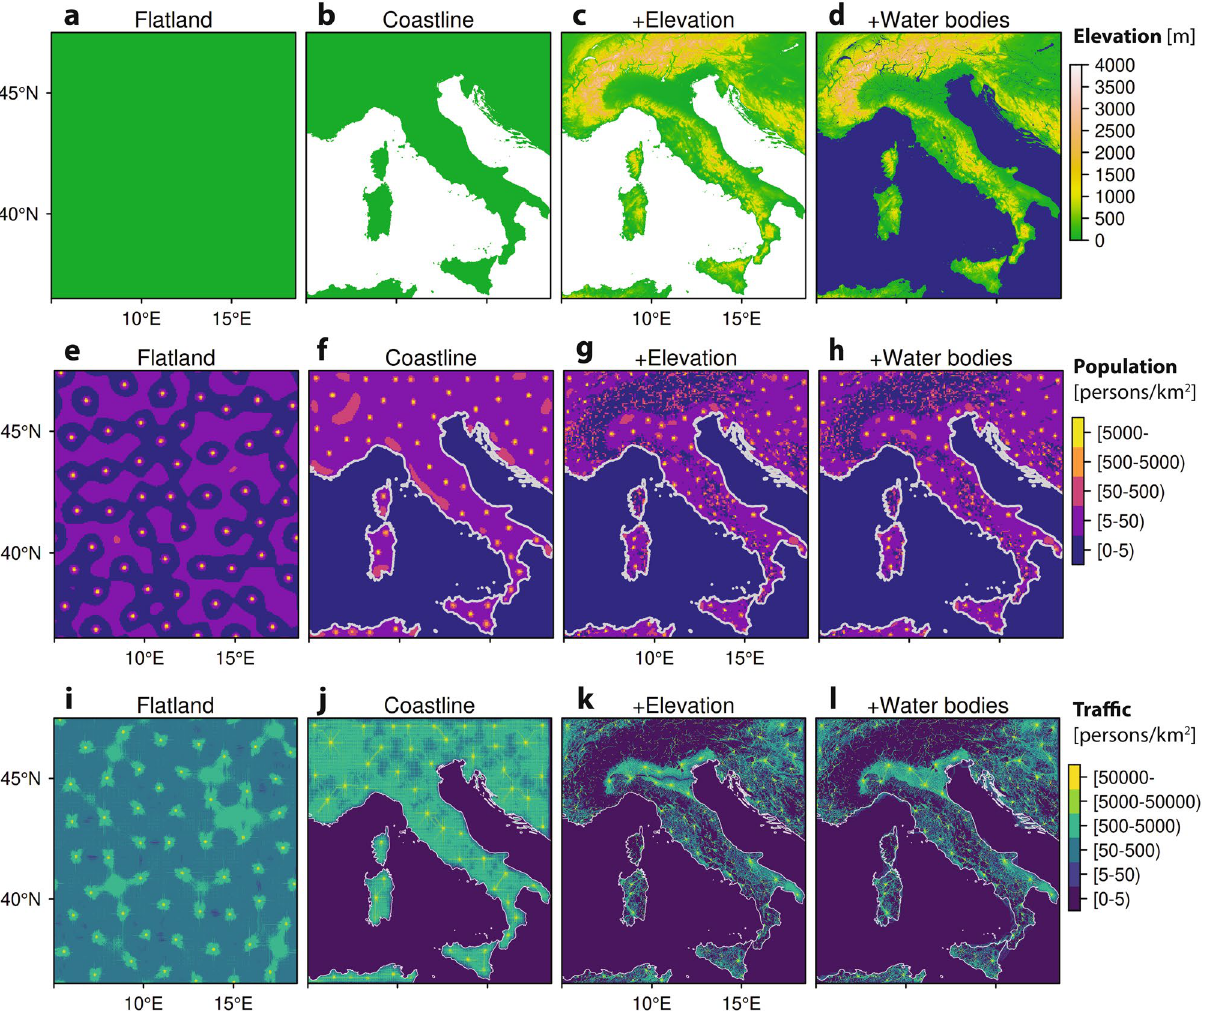
Figure 2. The effect of landscape factors on emergent geospatial patterns of both human population distribution and the interconnecting transport network. The underlying space is changed from an idealised flatland condition ( a ) to a more realistic one by sequentially adding coastlines ( b ), elevation ( c ), and water bodies ( d ), using Italy and its surrounding regions as a case study. By adding these factors, the emergent population pattern produced by the model shifts from a lattice-like Turing pattern with regular population sizes to a markedly heterogeneous distribution ( e–h ). In parallel, the transport network also emerges between centres ˆ W ( x ) of population, as depicted by the net traffic passing through each location (see Supplementary Information 3.8 for details) ( i–l